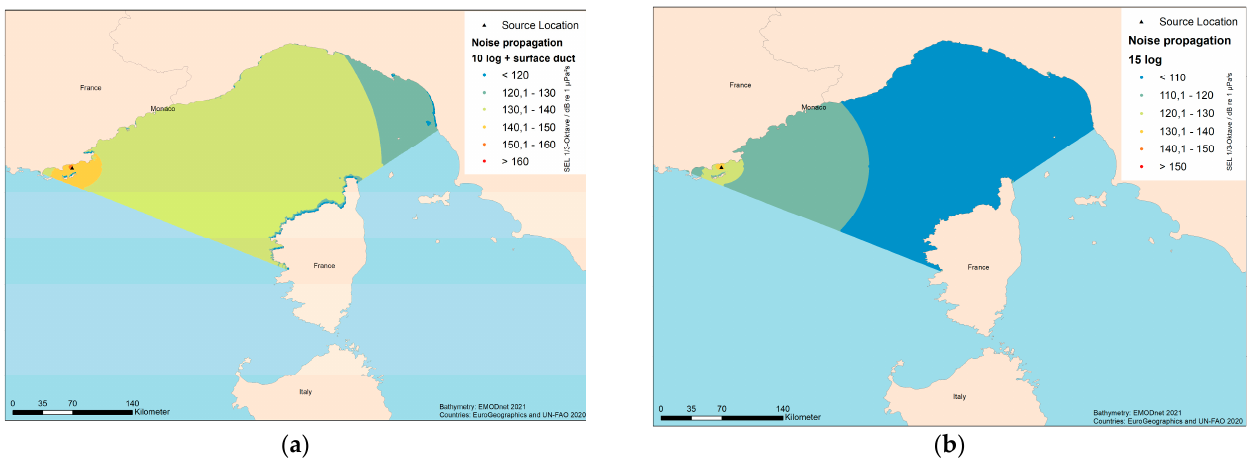
Figure 13. Pressure map due to an airgun array in the Mediterranean Sea using a 10-log law with a surface duct in ( a ) and using a 15-log law in ( b ).